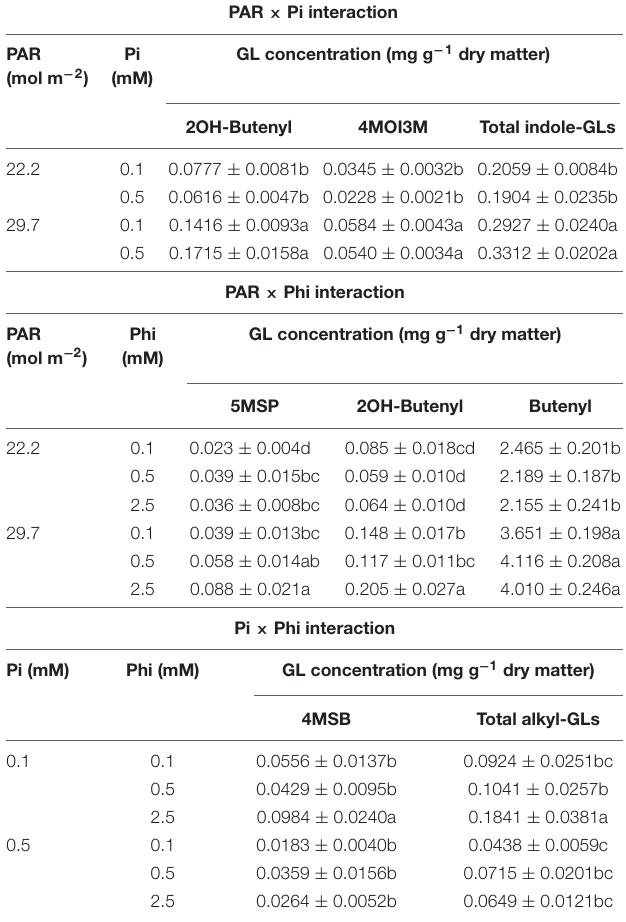
TABLE 3 | Mean daily photosynthetically active radiation (PAR) and phosphite (Phi) affecting glucosinolate (GL) concentrations in B. juncea cv. Red Giant. PAR × Phi